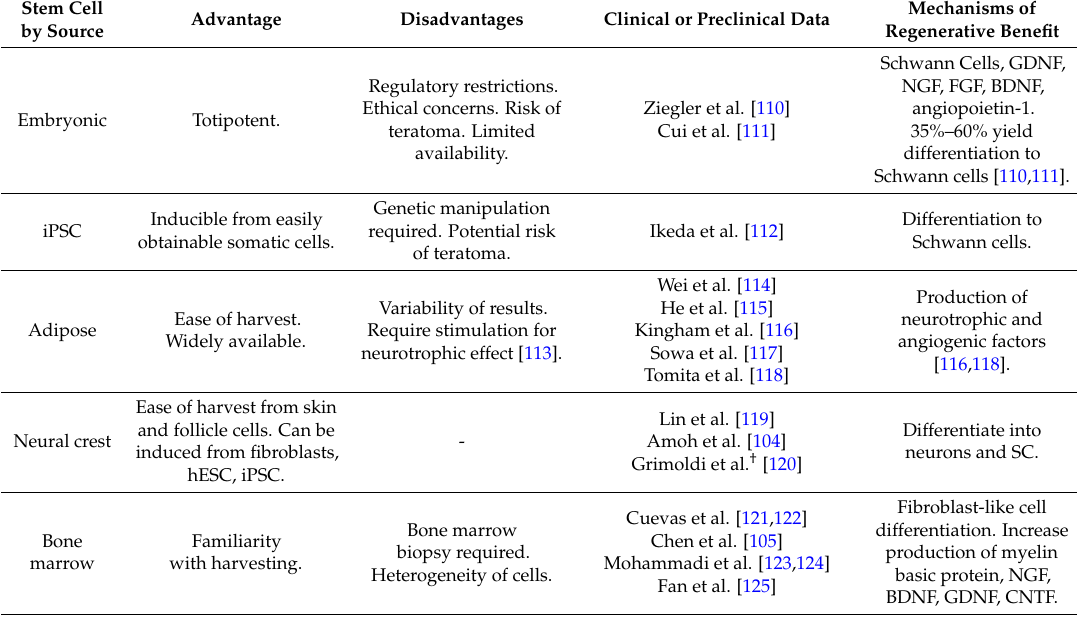
Table 2. Stem cell sources for peripheral nerve